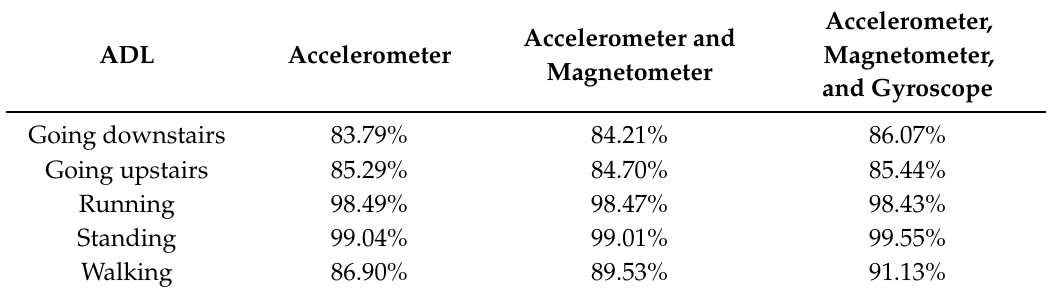
Table 5. Accuracies of ADL identification using AdaBoost with the decision tree implemented with the SMILE framework.